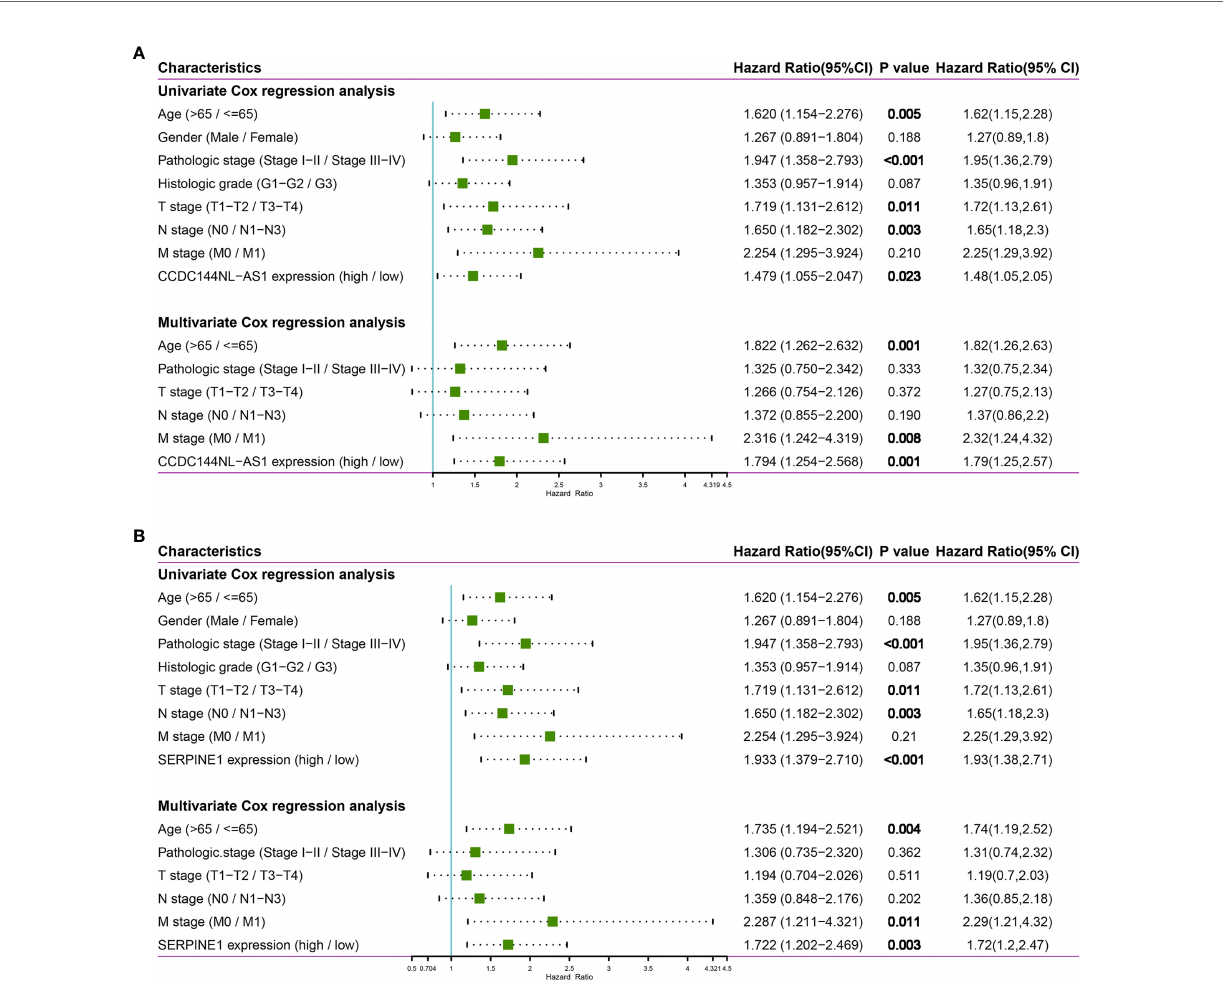
FIGURE 6 | Univariate and multivariate Cox regression analysis of CCDC144NL-AS1 and SERPINE1. (A) The forest plot of CCDC144NL-AS1. (B) The forest plot of